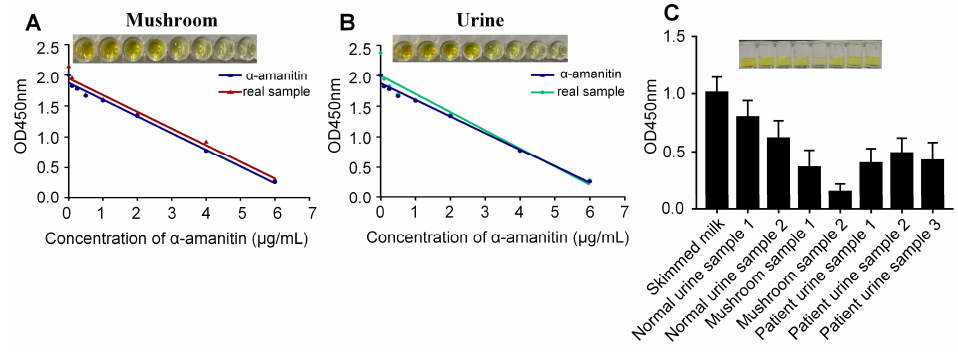
Figure 6 Experimental method validation. ( A ) Sensitivity detection. The concentrations of α-amanitin in standard and mushroom were 0, 0.1, 0.25, 0.5, 1, 2, 4, and 6 μg/mL, and the corresponding OD450 values were used to prepare the standard curve. Standard curve of α-amanitin in mushroom: y = −0.2701x + 1.945(R 2 = 0.969). ( B ) The concentrations of α-amanitin in standard and urine were 0, 0.1, 0.25, 0.5, 1, 2, 4, and 6 μg/mL, and the corresponding OD450 values were used to prepare the standard curve. Standard curve of α-amanitin in urine: y = −0.2969x + 1.996(R 2 = 0.94). ( C ) Determination of α-amanitin in the actual samples. Samples (mushroom leachate and urine) were tested with skim milk as a blank control.